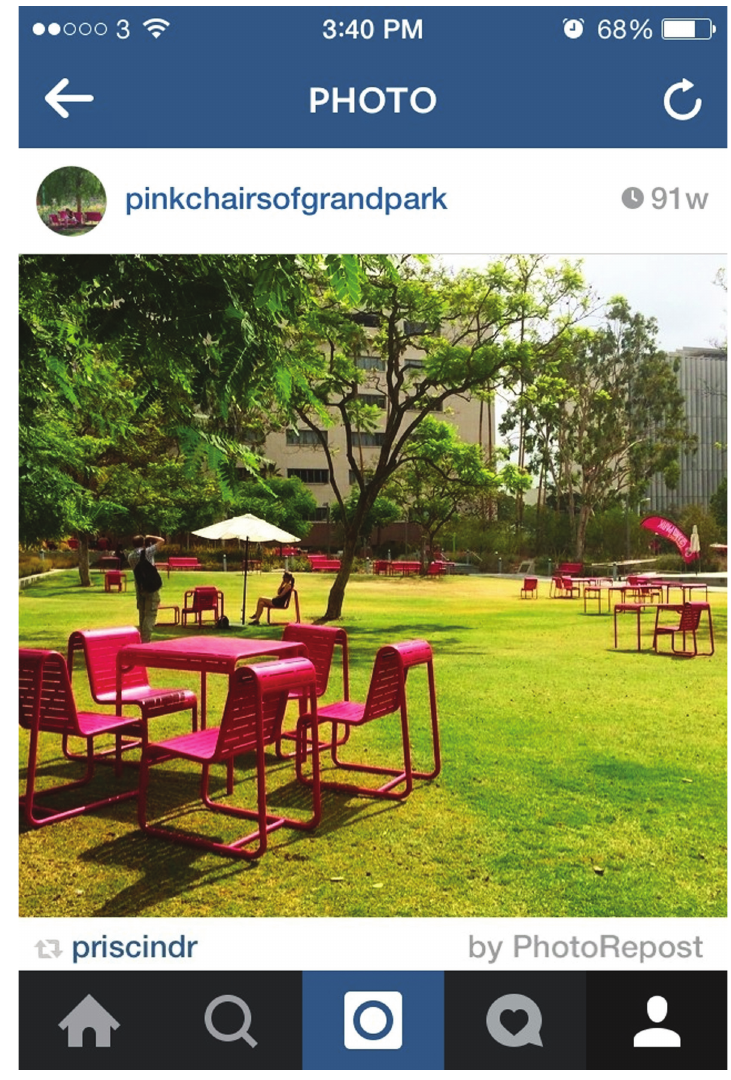
Figure 1: Screen shot of Instagram photograph, reposted by the author via @pinkchairsofgrandpark, originally by